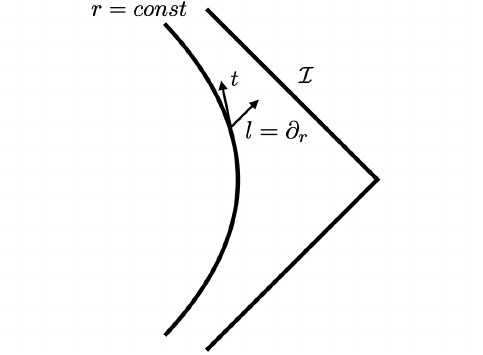
Figure 1 . The figure shows an idealized r = const hypersurface, the null vector l , which can be used to study its radial evolution, and the time-like vector t tangent to the